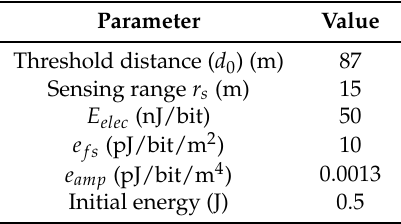
Table 1. Network